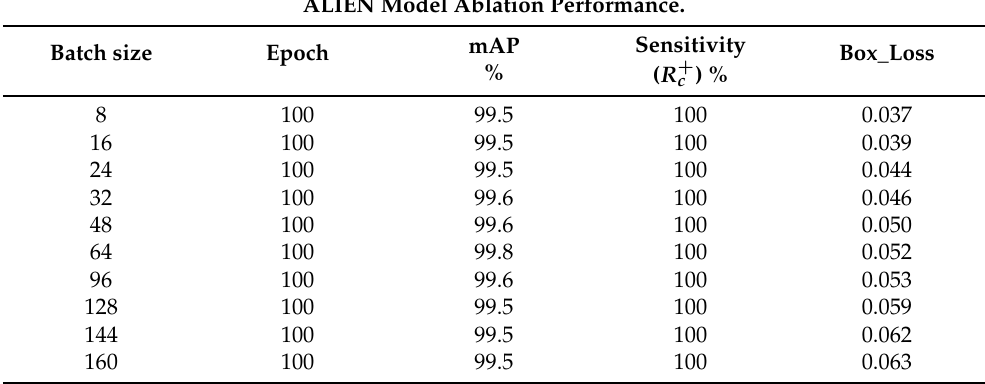
Table 5. Model ablation based on hyperparameter tuning. ALIEN Model Ablation